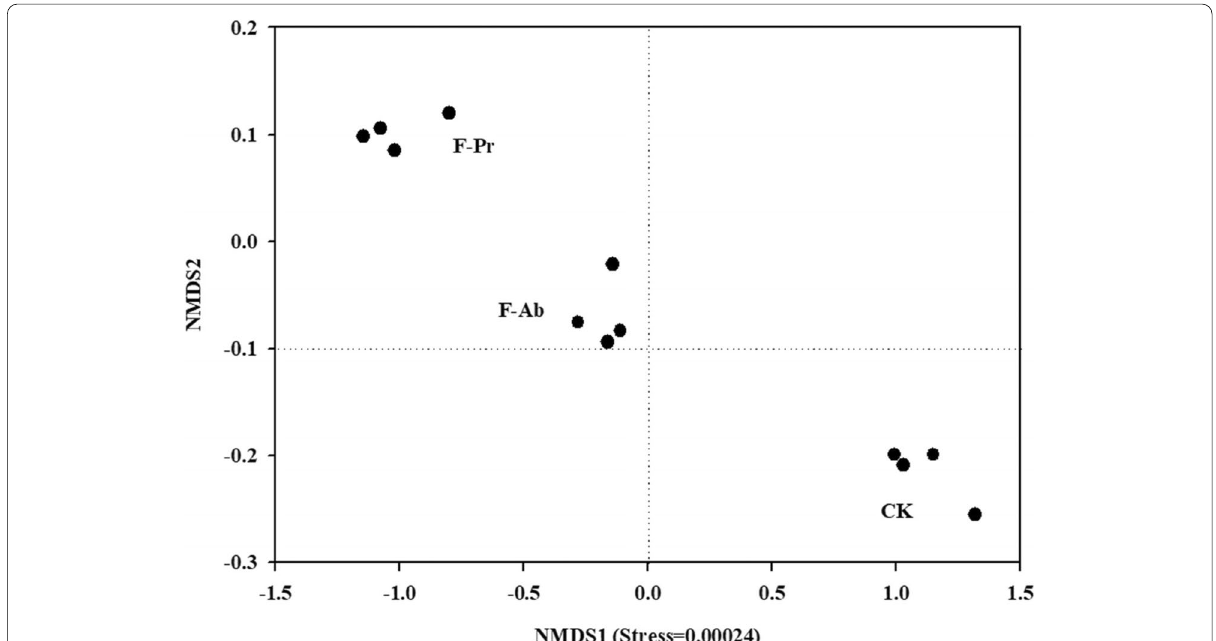
Fig. 2 Nonmetric multidimensional scaling (NMDS) of bacterial communities based on OTUs for all soil samples from covering Litsea cubeba plots of tea plantation. The NMDS1 stress was 0.00024. CK, control; F‑Ab, the vegetative branches cover treatment; F‑Pr, the fruit‑bearing branches cover treatment